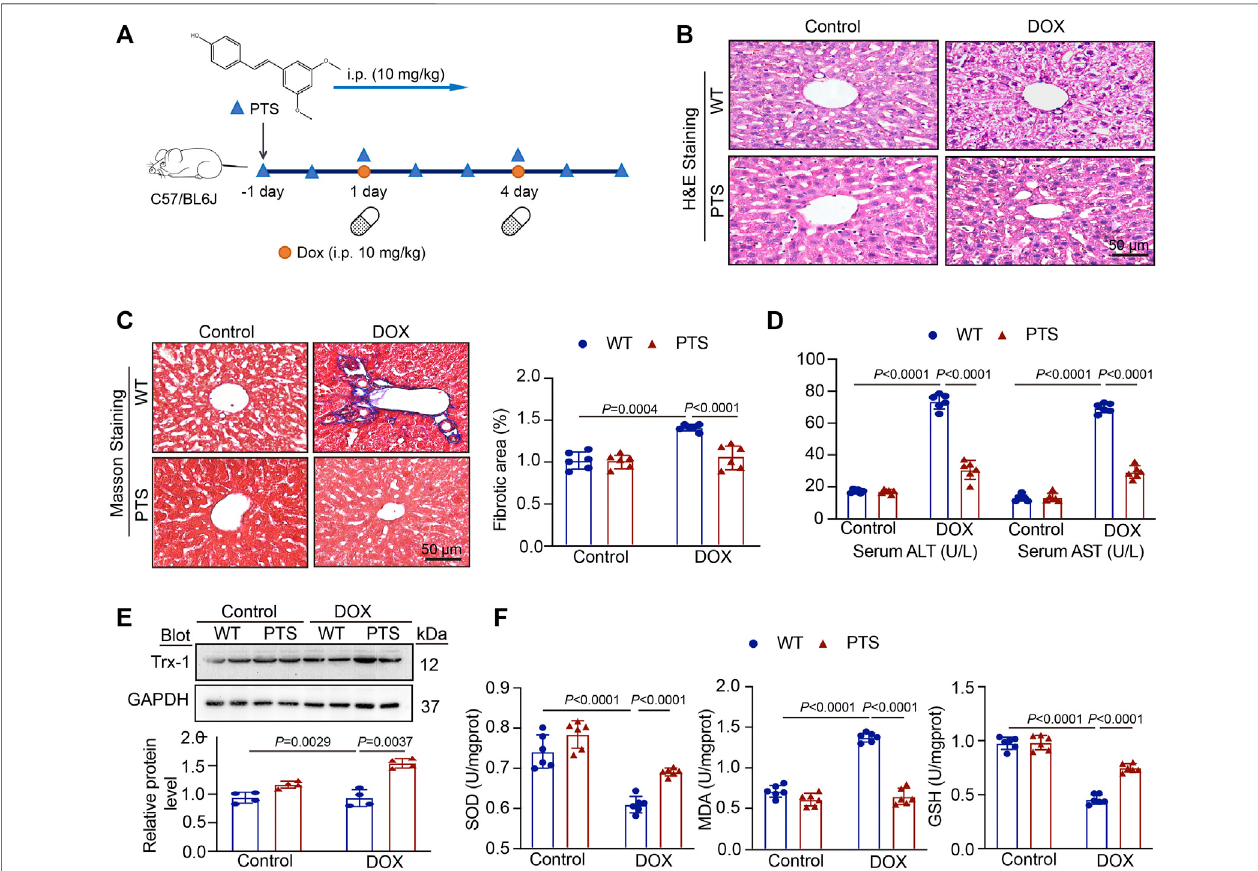
FIGURE 1 | PTS treatment prevents DOX-induced hepatotoxicity. (A) Diagrammatic representation of different mice treatments: PTS (10 mg/kg) was injected everydayforatotalof7times(onedaybeforeDOXtreatment);DOXadministrationwasconductedonday1andday4foratotalof2times(20 mg/kgcumulativedoseof DOX); (B) H& Estainingofeach groupwereanalyzed (scale bar = 50 μ m, n =6per group); (C) Massonstainingofeach group wasanalyzed(left, scalebar = 50 μ m), the quanti fi cation of the fi brotic area (right, n = 6); (D) The levels of serum ALT (left) and AST (right) in each group ( n = 6 per group); (E) Western blot analysis of Trx-1 protein in each group (up), the quanti fi cation of Trx-1 expression (down, n = 4 per group); (F) The levels of SOD (left), MDA (middle), and GSH in each group ( n = 6 per group).